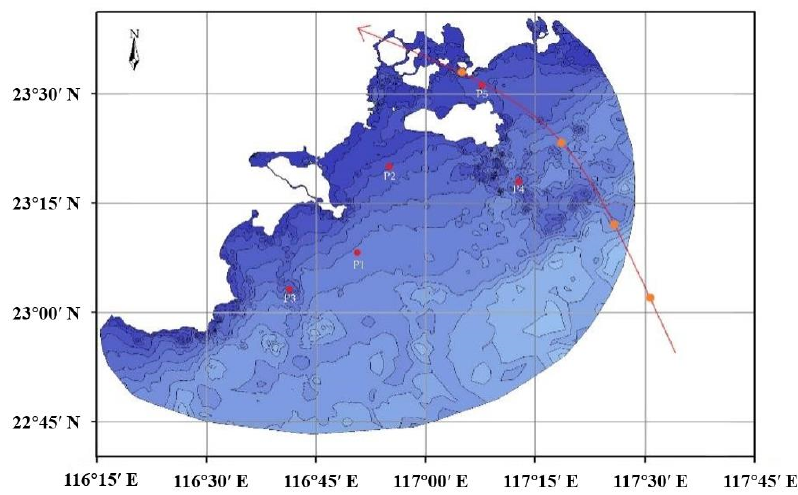
Figure 11. Path of typhoon “Mangkhut” in model and location of typhoon monitoring points.